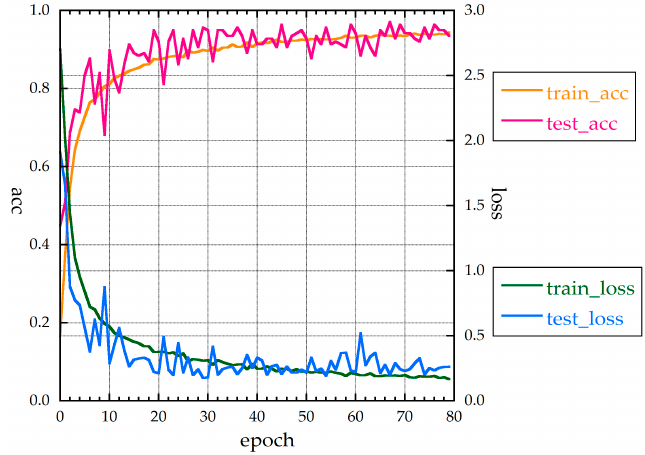
Figure 4. Accuracies and loss function values of MLP_S for 30 measurements without HQ.